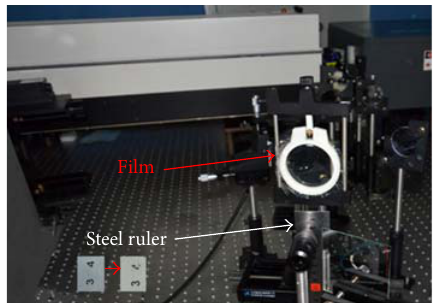
Figure 7: FEP film was used as debris shields.